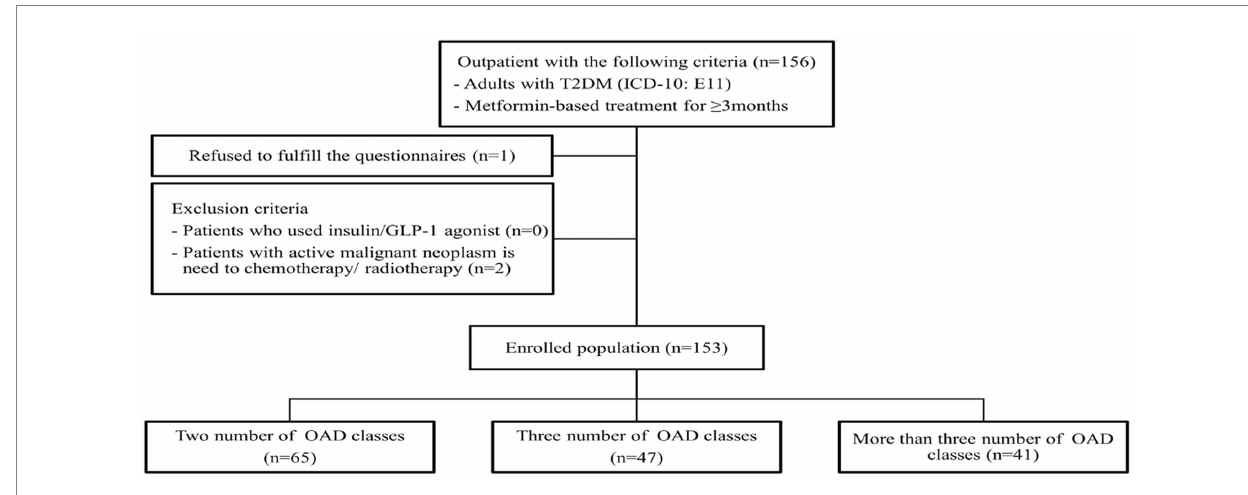
FIGURE 1 Study flow diagrams. T2DM, type 2 diabetes mellitus; OADs, oral anti-diabetic drugs; ICD-10, international classification of disease 10th